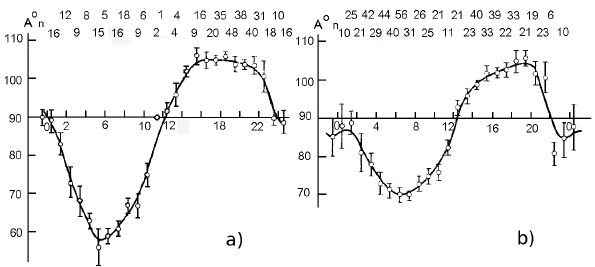
Figure 8. Diurnal variations (MLT) of the azimuths of elongated auroral forms at the stations Cape Chelyuskin (a) and Pyramida, Spitzbergen (b) . The number signifies the quantity of arcs occurring during the corresponding hour. The vertical lines indicate the mean quadratic errors (Starkov and Feldstein,